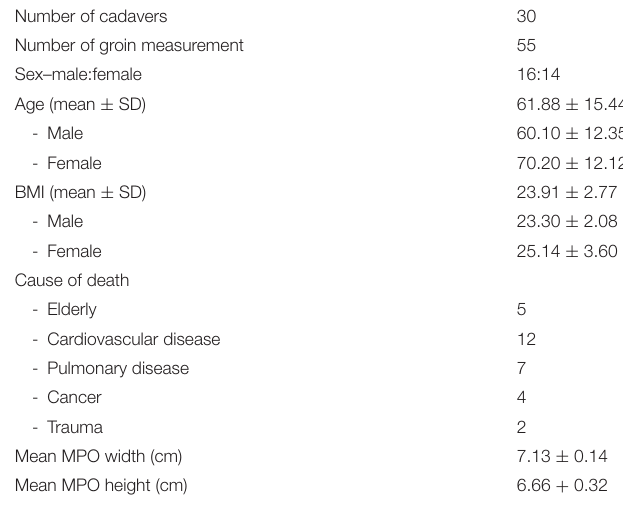
TABLE 1 | The baseline characteristic of